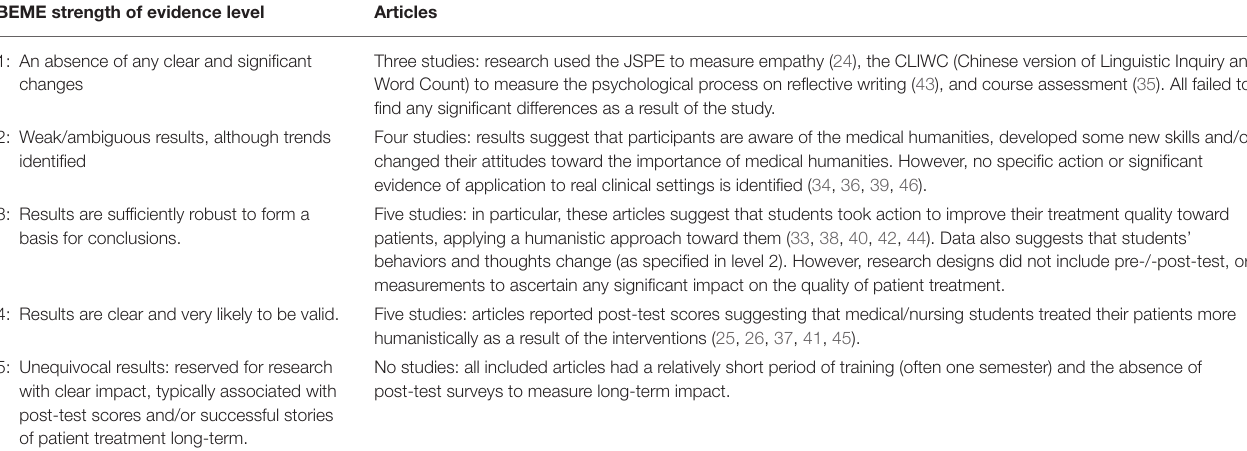
TABLE 3 | BEME strength of the evidence summary. BEME strength of evidence level